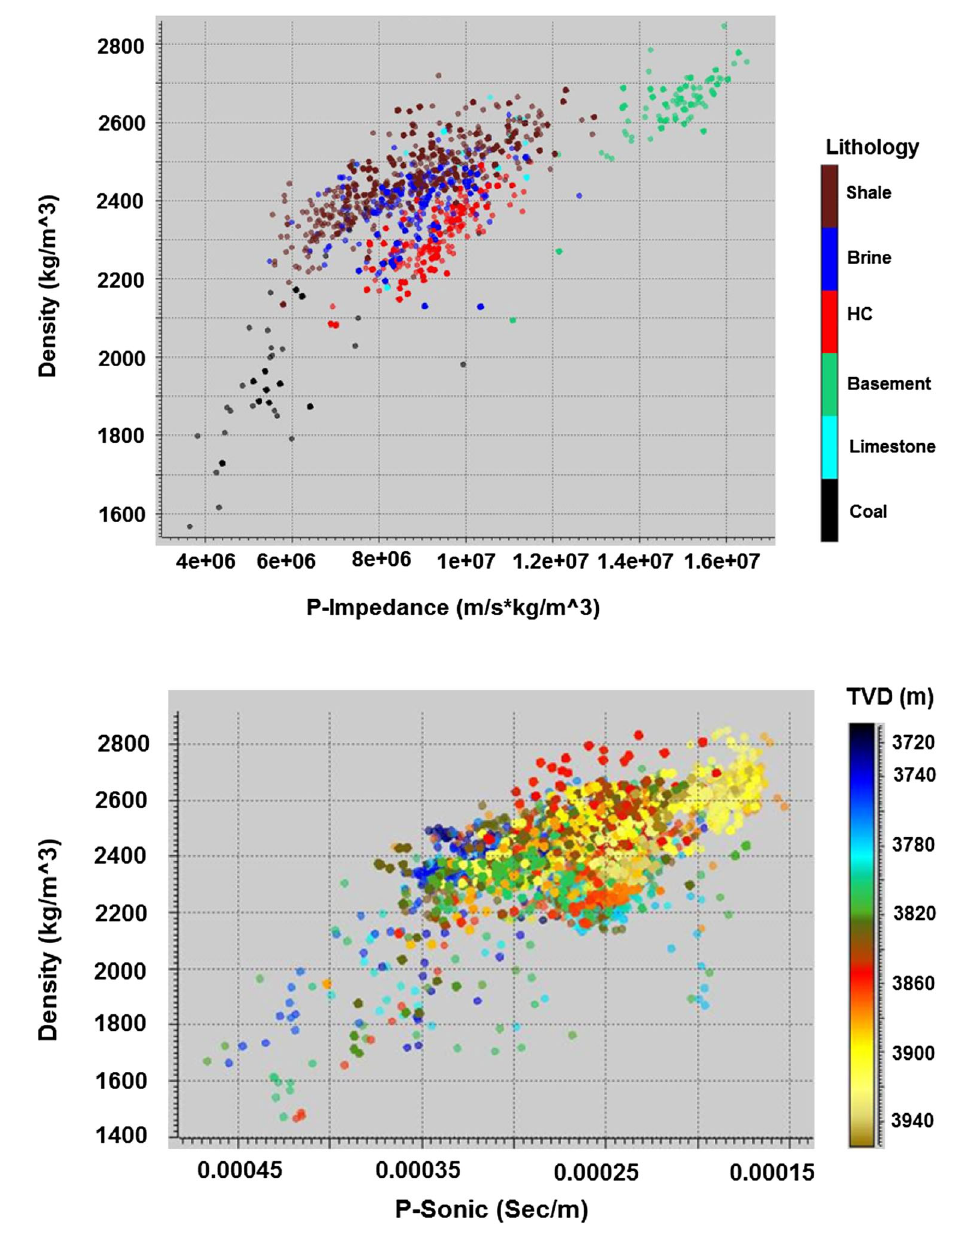
Fig. 22 Measured P-impedance versus measured density for all the wells colored by Litholog